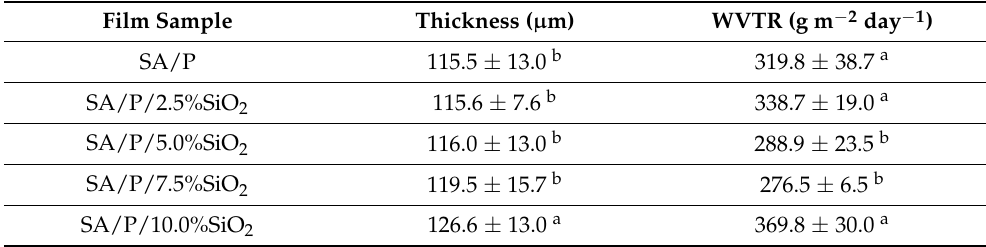
Table 2. Thickness and water-vapor transmission rate (WVTR) of SA/P and SA/P/SiO 2